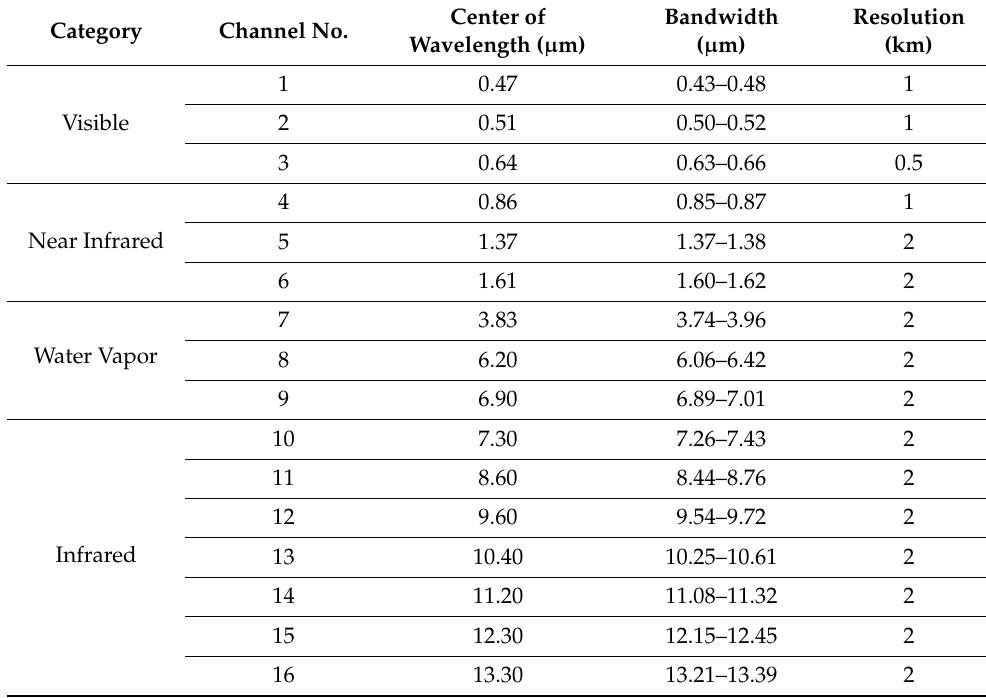
Table 2. GK2A channel information including the center of wavelength, bandwidth, and spatial resolution. Category Channel